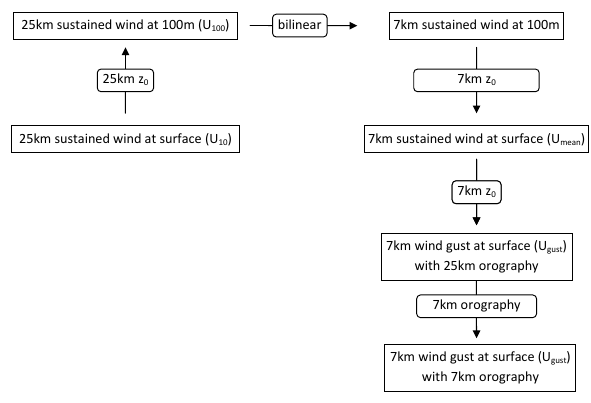
Fig. 2 Schematic of the process of downscaling of the RCM 25 km mean wind speed to 7 km wind gust speed. Fig. 2. Schematic of the process of downscaling of the RCM 25km mean wind speed to 7km wind gust